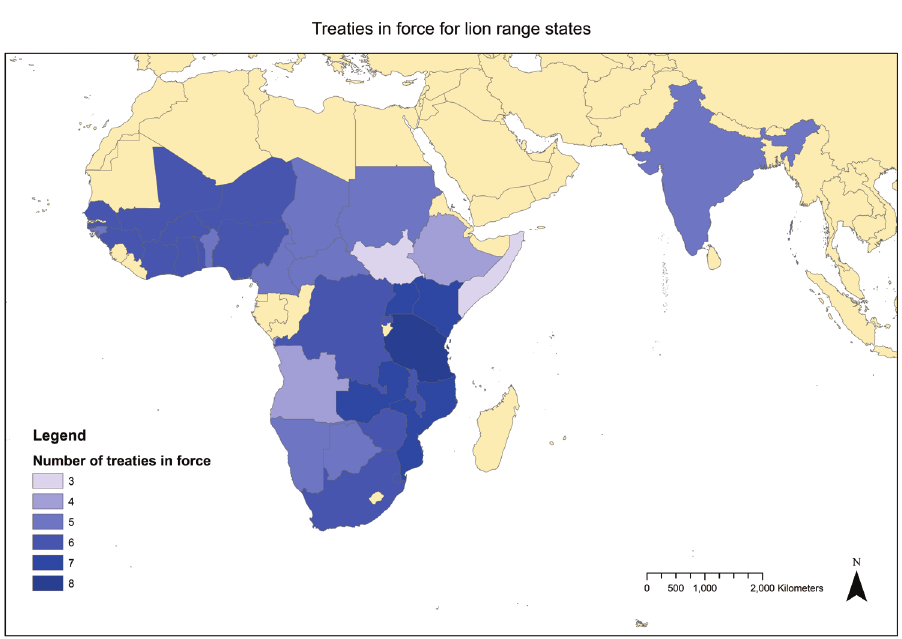
Figure 2. The map shows to how many of the 8 lion-related treaties mentioned in Table 2 each lion range state is a contracting